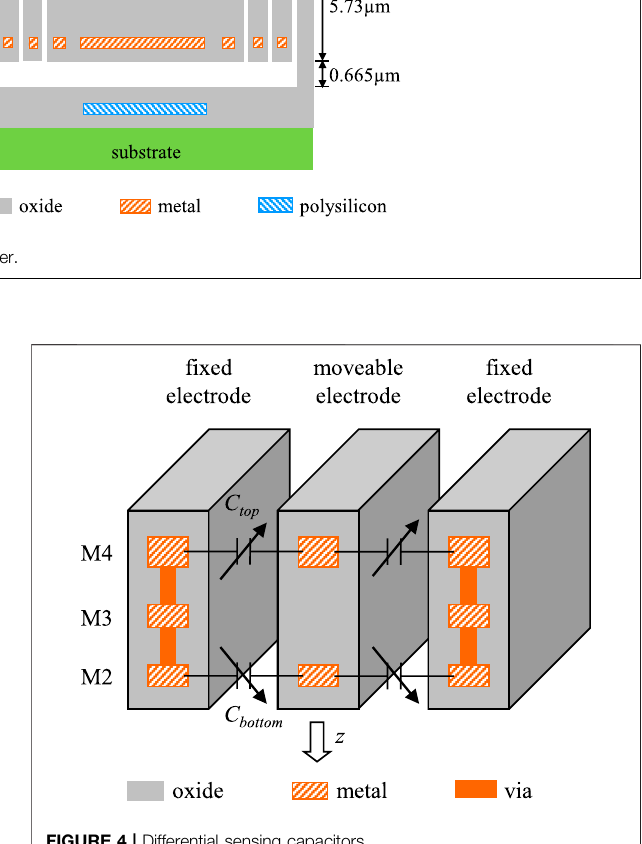
FIGURE 4 | Differential sensing